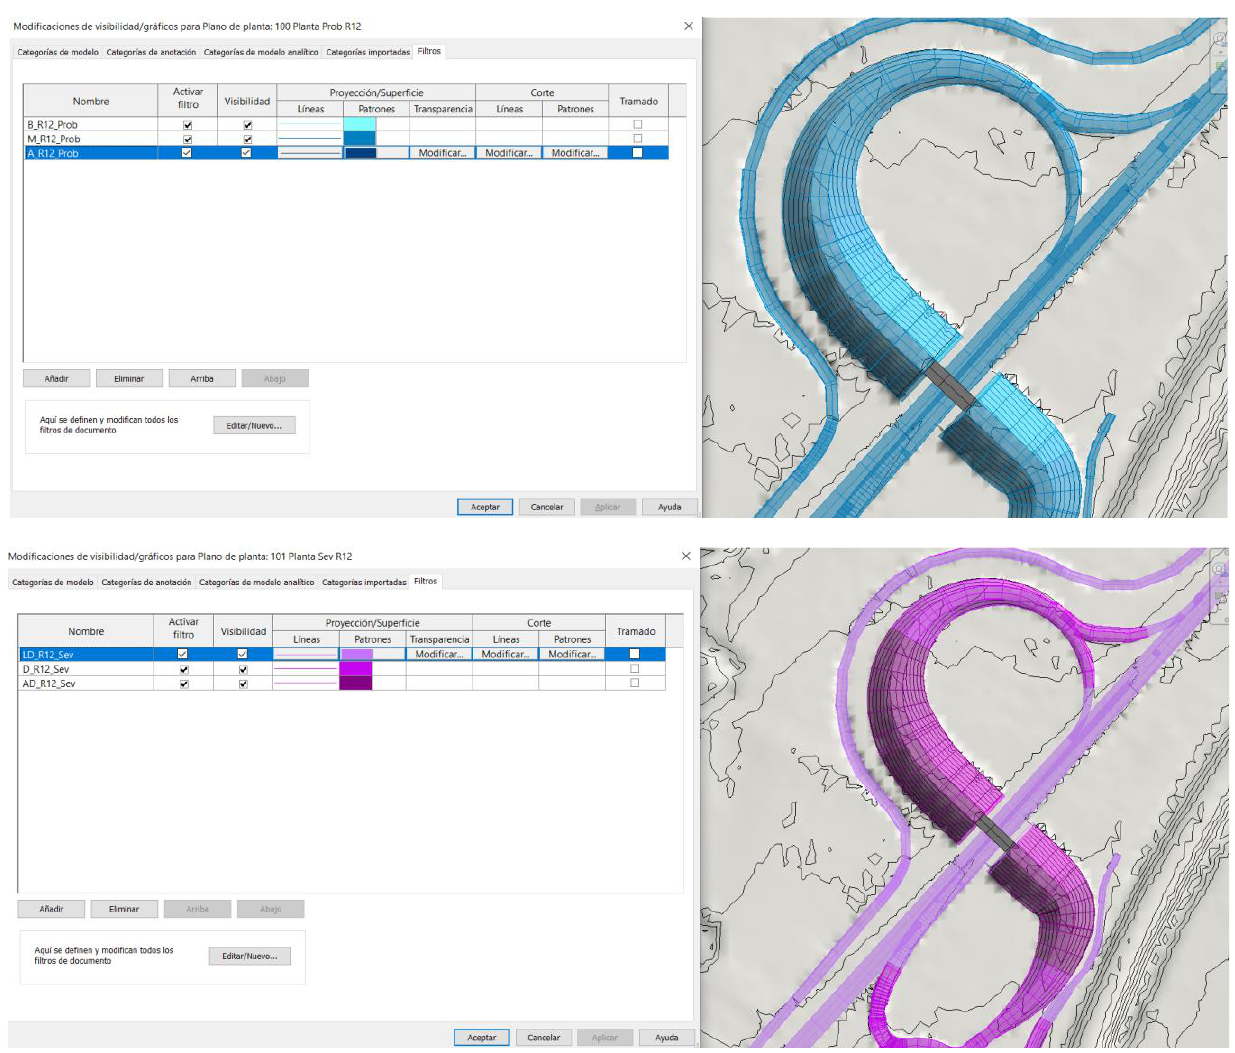
Figure 6. Execution of filters in the analysis of the risk of entrapment due to overturning in the bituminous road surface work unit (risk R12). Probability in ( upper ) figure and gravity in the ( lower ) figure.